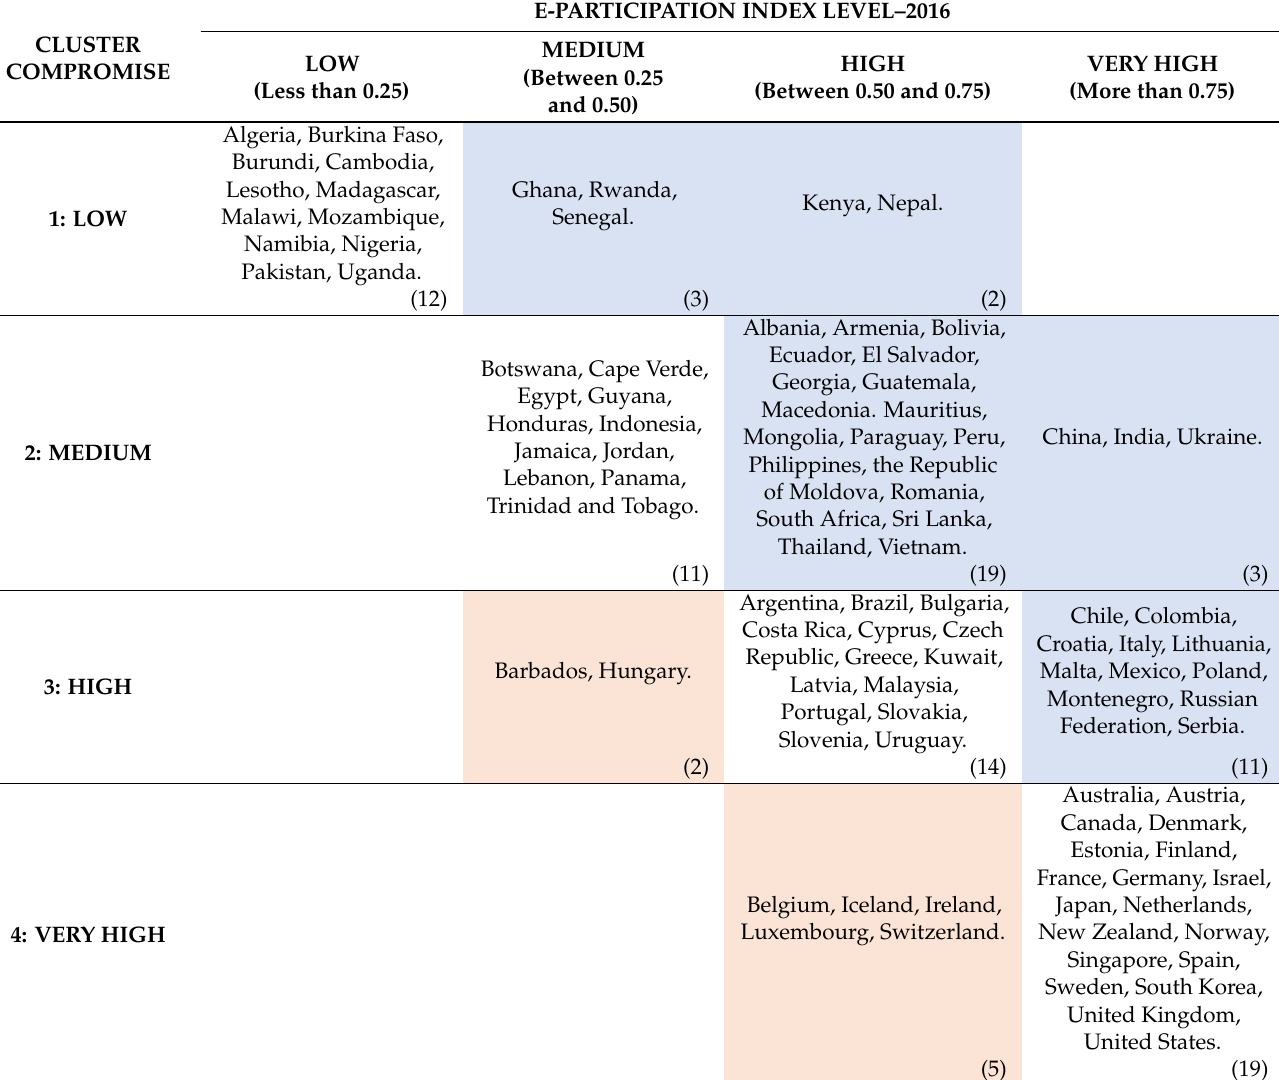
Table 2. Countries with level e-participation index 2016 and classified compromise with the ward